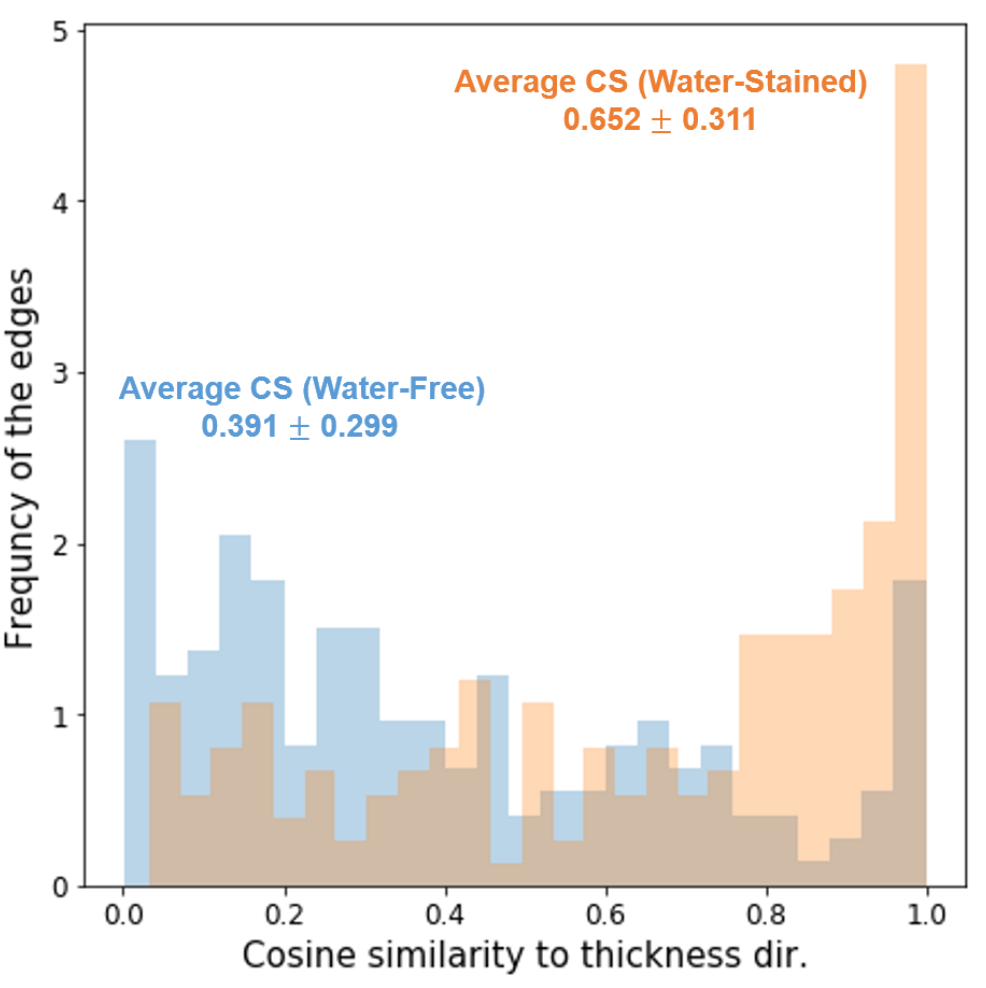
Figure 8. Cosine similarity distributions for all detected edge segments from SEM images in Figure 7a,f.